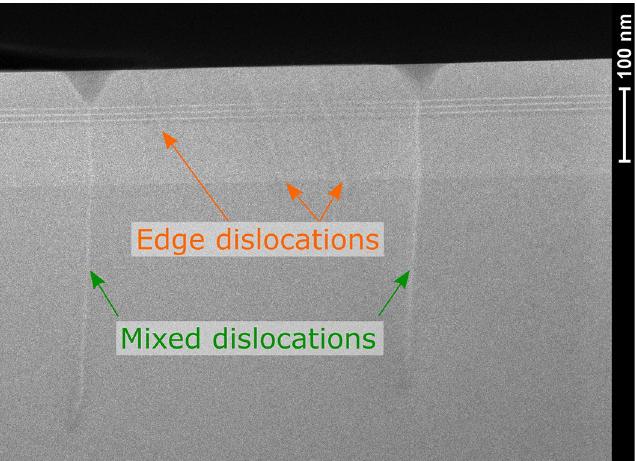
Figure 11. TEM picture of QW structure with visible edge and mixed